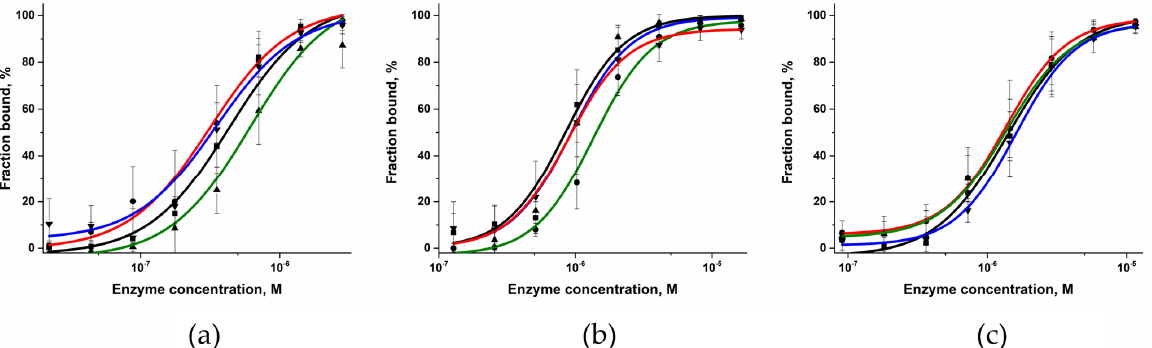
Figure 5. Efficiency of binding of WT Polβ ( a ), G118V ( b ), or R149I ( c ) to DNA substrates containing different nucleotides opposite the gap (black: Gap_A ( ■ ), red: Gap_T ( ● ), green: Gap_G ( ▲ ), and blue: Gap_C ( ▼ )). Table 2. Dissociation constants K d (µM) of the enzyme–DNA complex.